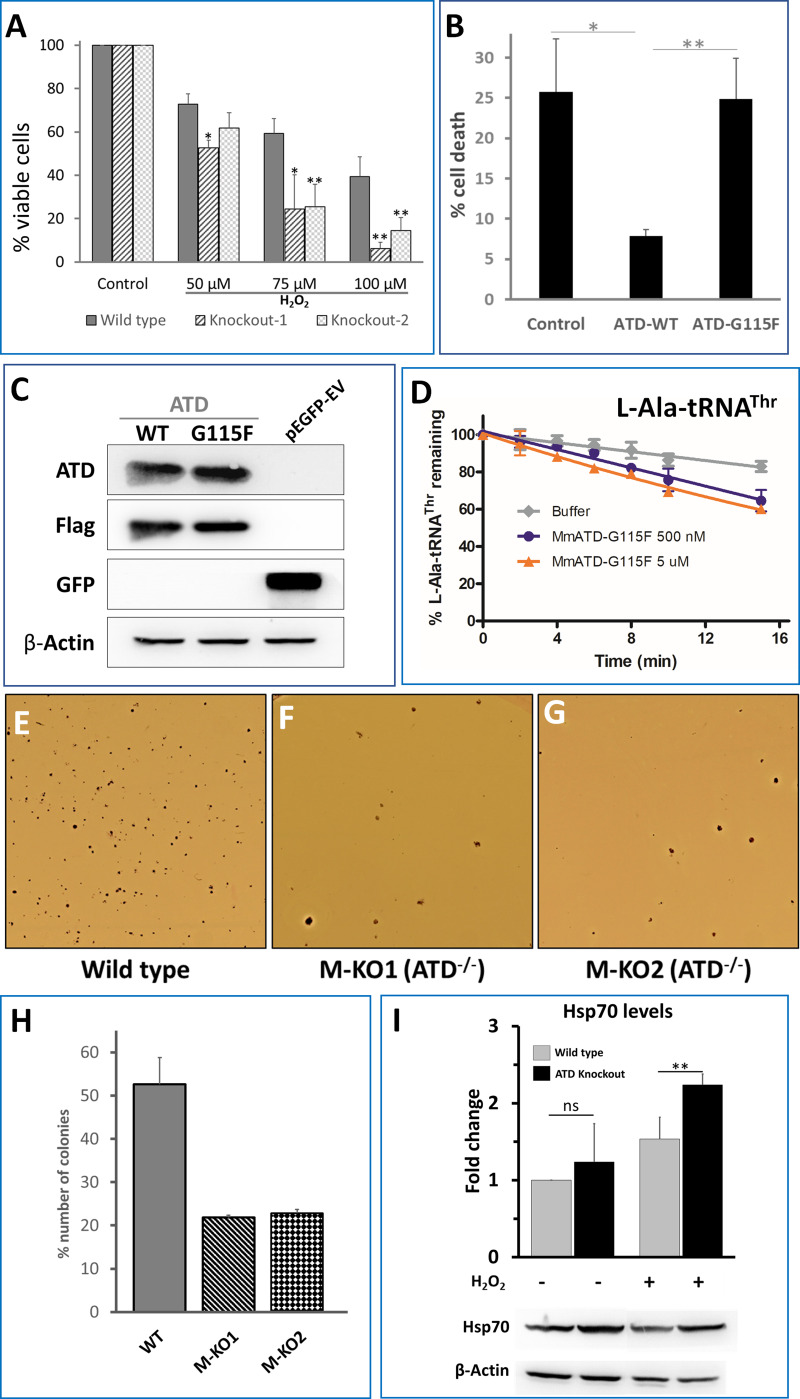
ATD is essential during oxidative stress.(A) Cell viability assay using MTT assay. Both wild type and knockout cells (knockout 1 and knockout 2 are two lines created using CRISPR-Cas9) are treated with varying concentrations of H2O2 followed by 24 hr of incubation and assessed for viability. The p-value is a comparison between the wild type and knockout at the same concentration of H2O2. (B) Overexpression of ATD rescues H2O2 induced cell toxicity: ATD knockout cells of HEK293T were transfected with a vector containing no insert, wild type ATD and inactive mutant of ATD, and treated with 75 µM H2O2 followed by MTT assay, all the values are normalized using H2O2-untreated cells as control. * indicates p-value<0.1 and ** indicates p-value<0.01 obtained by doing student’s t-test. (C) Immunoblotting of ATD knockout cells expressing FLAG-tagged ATD using Anti-ATD and Anti-FLAG antibody. (D) Deacylation of L-Ala-tRNAThr by G115F mutant of MmATD. Data points correspond to the mean of three independent readings and error bars represent one standard deviation. (E–G) Leishman-stained colonies of mouse ES cells after growing the wild type and ATD knockout cells in presence of 0.1X βME. (H) Graph representing the number of colonies formed by wild type E14Tg2a (mouse embryonic stem cells) and ATD knockout E14Tg2a cells (M-KO represents ATD knockout of MES cells, 1 and 2 refer to the clone number) formed when grown in media containing 0.1X βME compared to that of 1X βME (100 µM). (I) Probing for the markers of protein mistranslation, Hsp70, after exposing the wild type and ATD knockout cells to oxidative stress (75 µM of H2O2) for 6 hr. (p-value for untreated wild type and knockout is insignificant (ns) and the p-value between H2O2-treated wild type and control is 0.023, denoted by ** obtained by doing student’s t-test).Figure 4—source data 1.Deacylation of L-Ala-tRNAThr by G115F mutant of ATD.